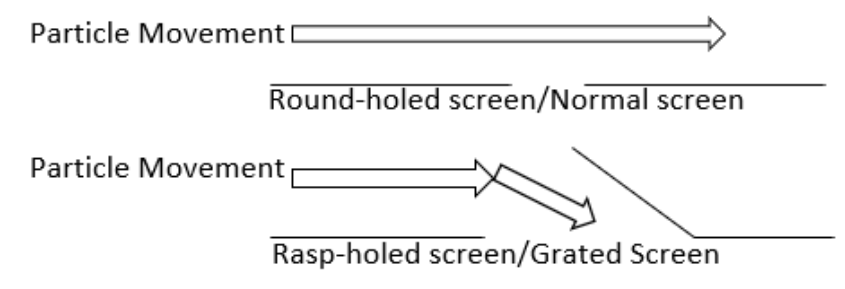
Figure 8. Comparison of particle movement between a normal screen (round shaped screen) and grated screen.